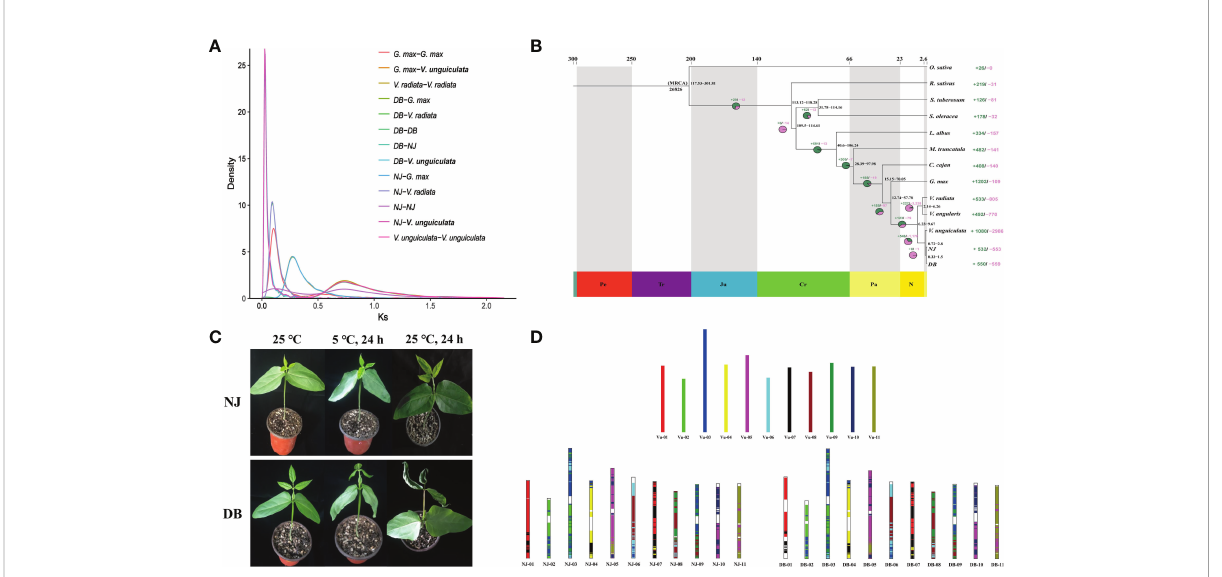
FIGURE 1 Phylogenetic relationships of asparagus bean and its genomic comparison with IT97K-499-35. (A) . Frequency distribution of Ks values between syntenic genes of the compared genomes. (B) Estimated differentiation time between asparagus bean and other plants, with O. sativa as the outgroup. Expanding and contracting gene families were identi fi ed using CAFE, and 26,826 families were deduced to exist in the most recent common ancestor (MCRA). Gene families that expand (green in the pie chart) or shrink (red in the pie chart) are plotted in the pie chart. (C) . Comparison of NJ and DB phenotypes under low-temperature stress (5 °C). (D) . Collinearity of chromosomes of NJ and DB with